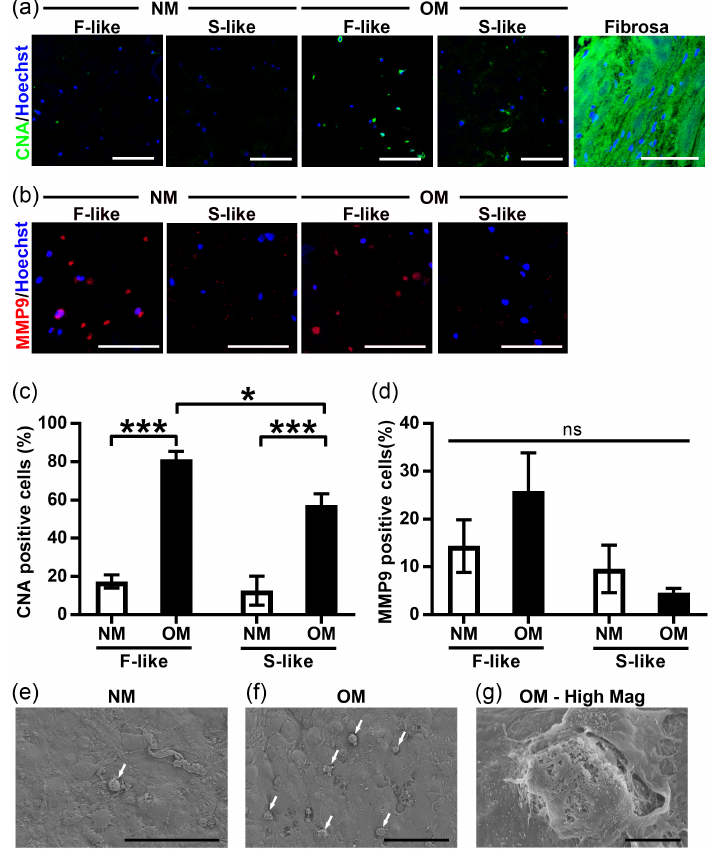
Figure 6. OM stimulation induced VIC pathogenesis in 3D-bioprinted hydrogels: ( a , c ) VICs isolated from non-diseased human AV and exposed to OM (and not NM) for 14 days stimulated production of collagen, as shown by representative images of collagen-binding probe (CNA35) fluorescence; ( b , d ) OM-treated F-like VICs trended towards increased expression of the ECM-degrading collagenase enzyme MMP-9 (representative immunofluorescence images). Mean ± SEM; * p < 0.05, *** p < 0.001; n = three samples per condition (three images per sample); scale bar = 200 µ m; ( e – g ) SEM of hydrogels showed that OM treatment drove formation of in vivo-like microcalcific nodules (white arrows), scale bar = 100 µ m ( e , f ) or 10 µ m ( g